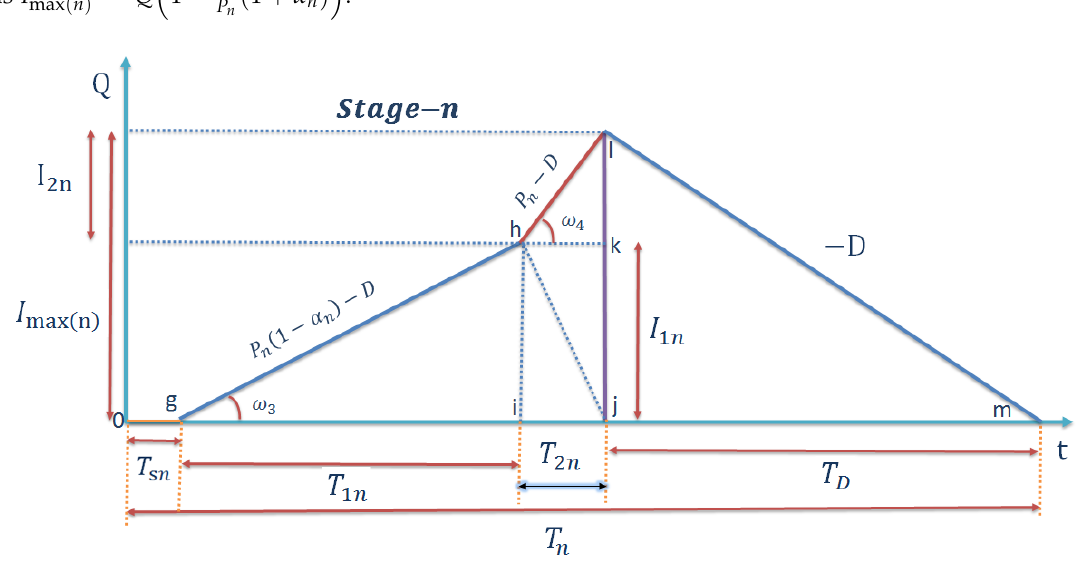
Figure 2. Inventory diagram of th k production stage.